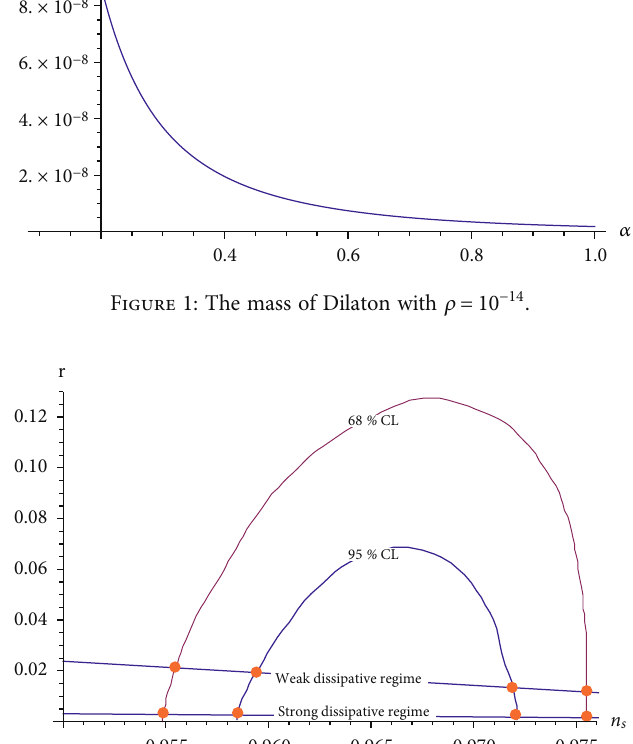
Figure 2: The function r depends on n